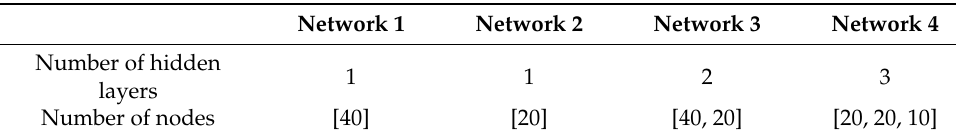
Table 3. Four networks with different hidden layer